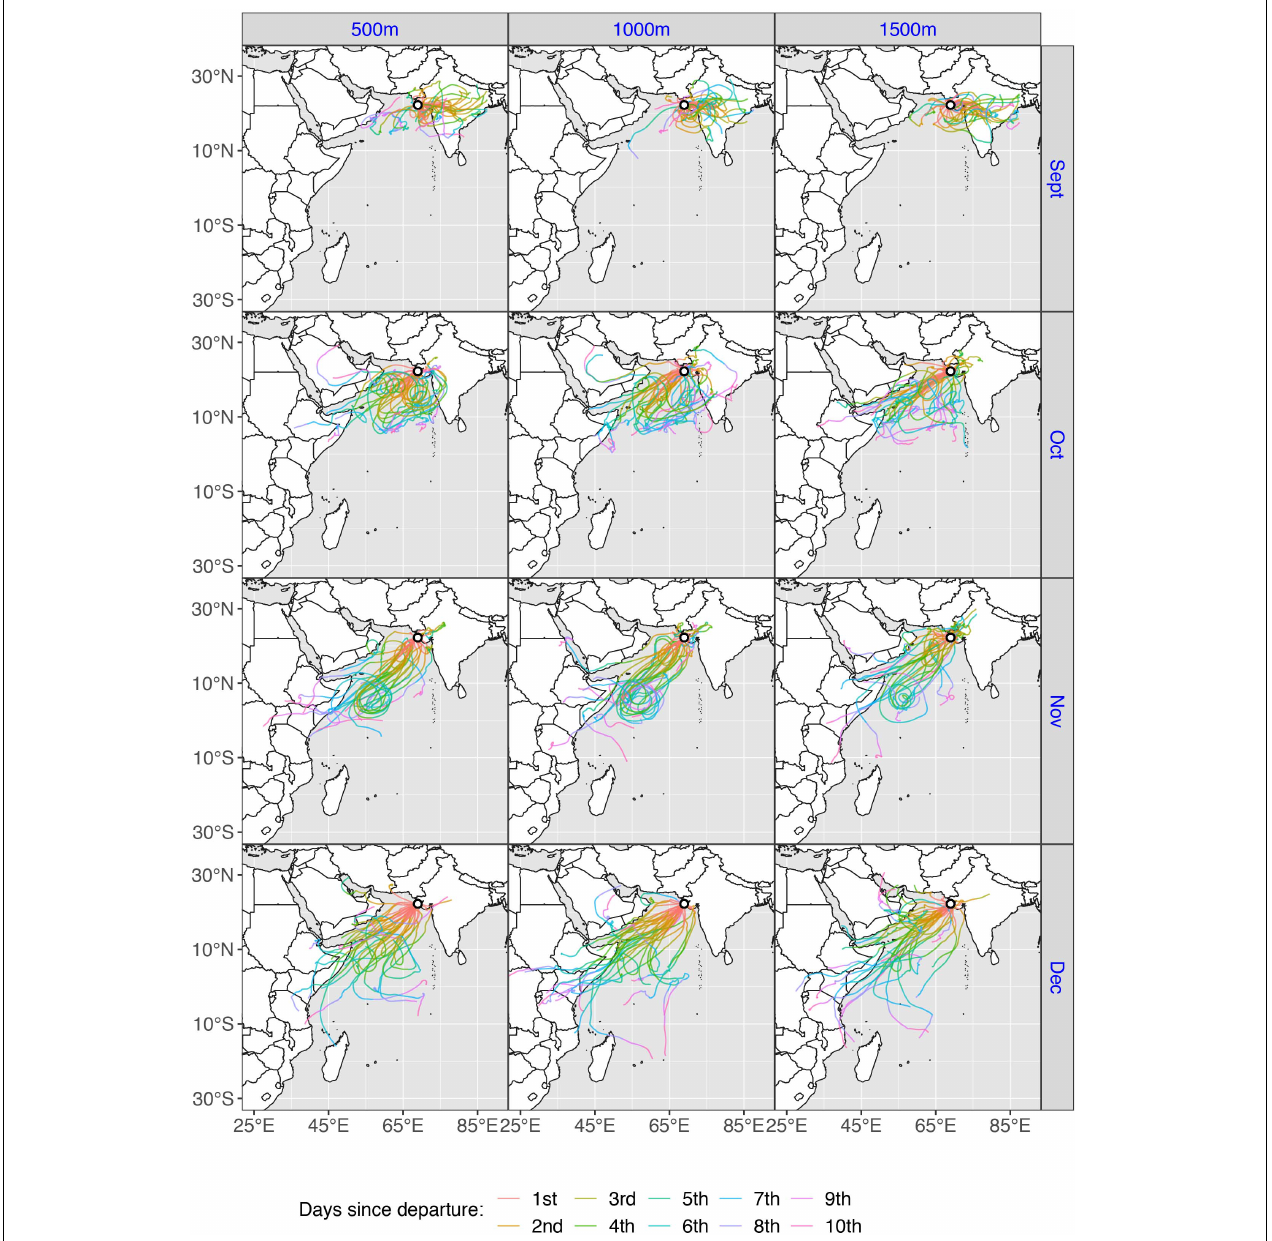
FIGURE 4 | Autumn wind trajectories ( N = 366), during September–December, for three starting heights (500, 1,000, and 1,500 m) from the departure site Gwarka lighthouse, Gujarat, northern India. Colors denote the number of days since departure (1–10). As the model adheres to a limited geographical scope, trajectories that exceeded the boundary (approximately 87 ◦ E longitude) will stop, thus trajectories traveling eastward across the Bengal Sea are cut